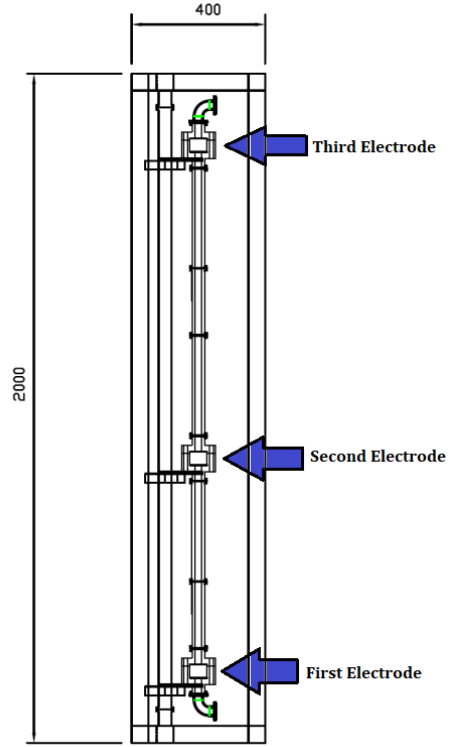
Figure 2. Applicator arrangement and electrode position.